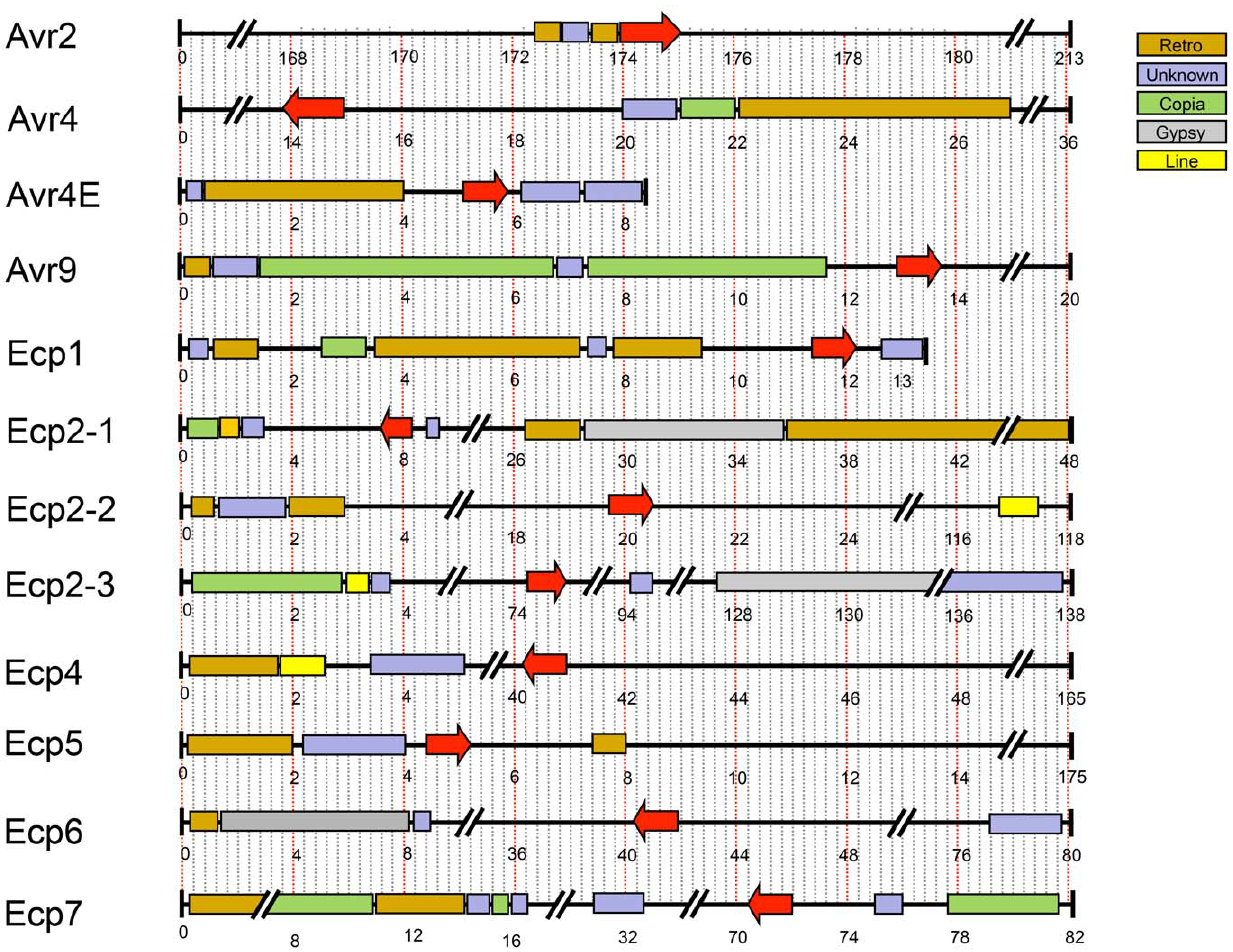
Figure 5. Repetitive regions flanking known effectors of Cladosporiumfulvum . Scaffolds harboring sequenced C. fulvum effector genes with flanking repeats. Repeat regions longer than 200-bp are shown, with different types indicated in different color code. Red arrows depict the effector genes and sizes are in kb. The sizes of scaffolds range from 8 to 213-kb but some are shortened to fit the figure due to differences in size.